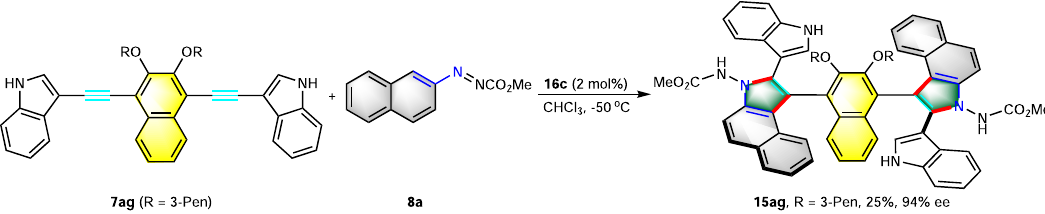
Fig. 3 Construction of diaxial compound 15ag. The reaction was carried out with 7ag (0.05 mmol), 8a (0.125mmol), and 16c (0.002 mmol) in CHCl 3 (0.5 mL) at − 50 °C under N 2 .